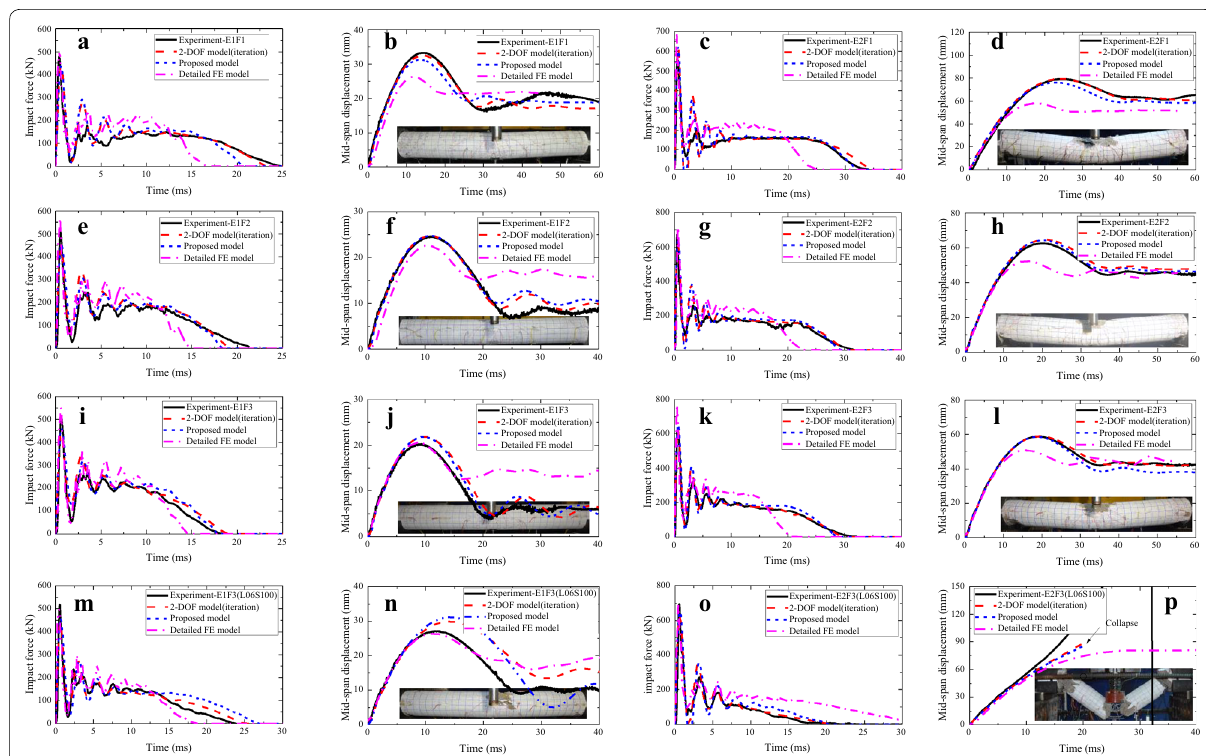
Fig. 11 Impact forces and mid-span displacements obtained from the experiments and the simplified